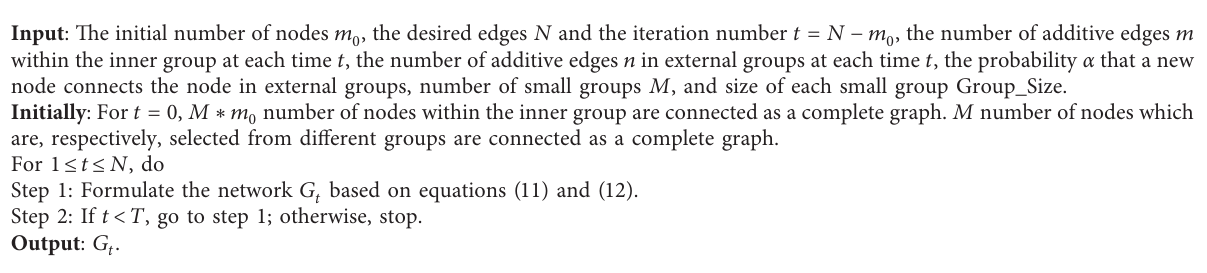
, the number of additive edges m 0